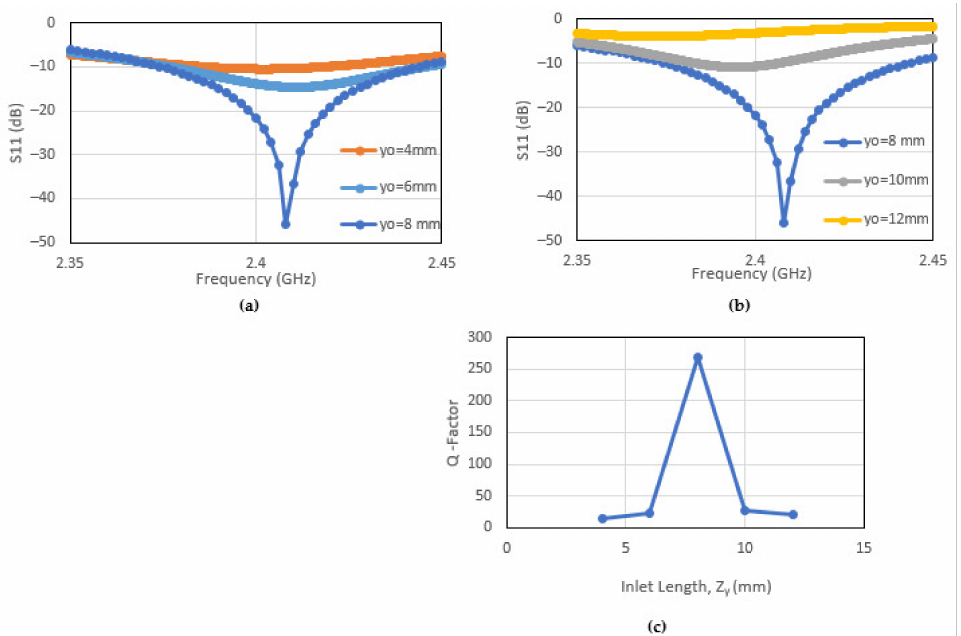
Figure 7. Resonant behavior of patch antenna as a function of changing length of recessed region, Z y . ( a )—reduction in Z y from 8 mm; ( b )—increase in Z y from 8 mm; and ( c )—the Q Factor.